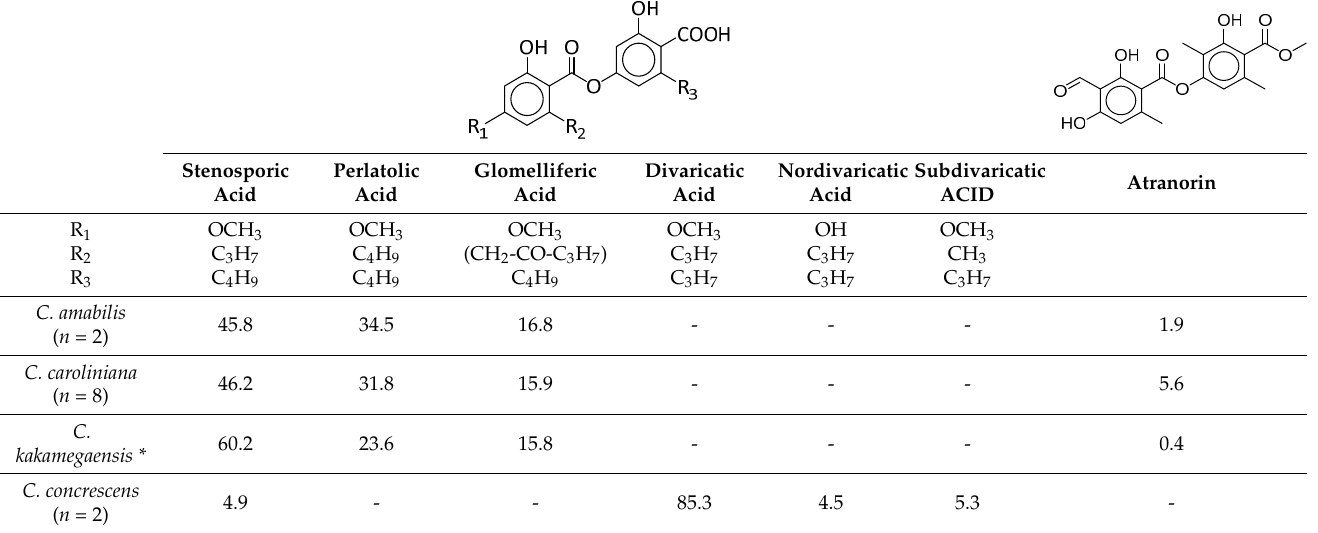
Table 1. Relative amount percentages of metabolites found in Canoparmelia caroliniana , C. amabilis , C. kakamegaensis and C. concrescens , based on HPLC-DAD analysis.